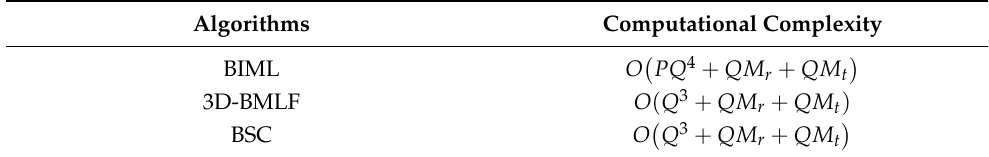
Table 3. Computational complexity of the three